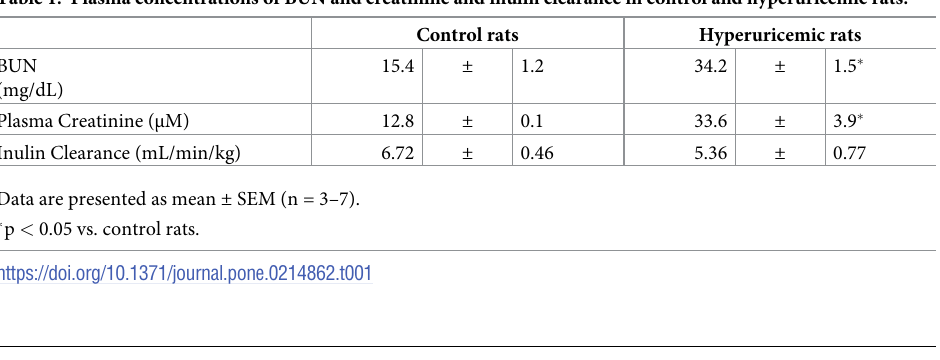
Table 1. Plasma concentrations of BUN and creatinine and inulin clearance in control and hyperuricemic